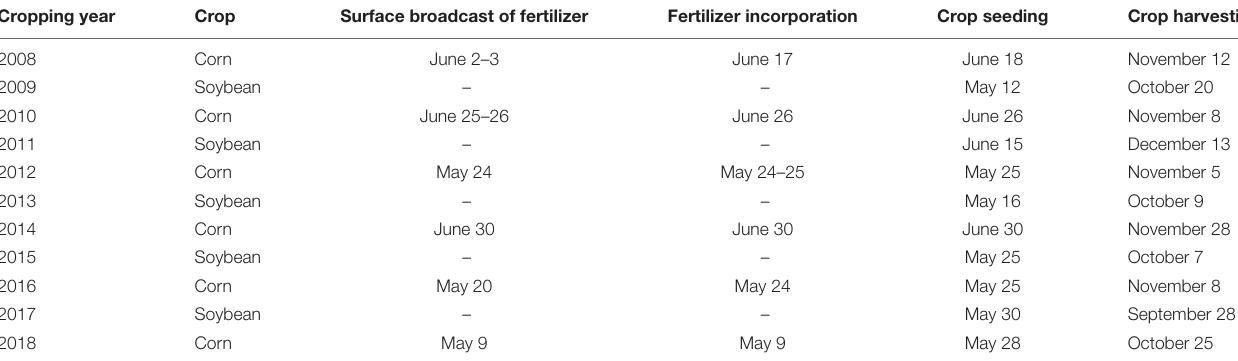
TABLE 1 | Agronomic practices of the study site,